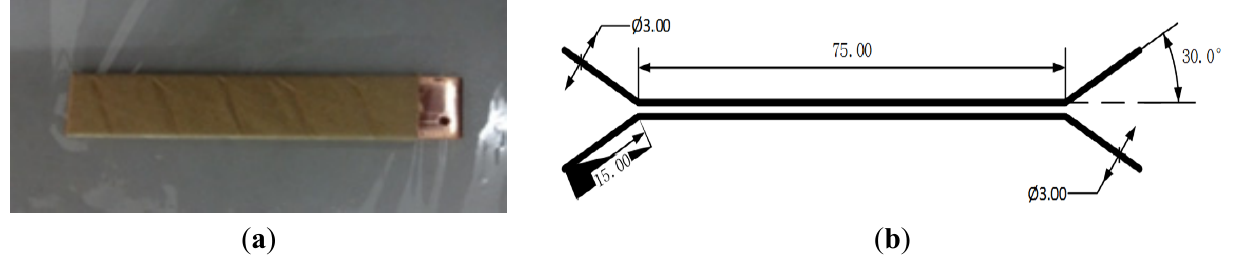
Figure 1. Paper-wrapped copper winding and dimension pig-tail model. ( a ) winding; ( b ) dimension of pig-tail